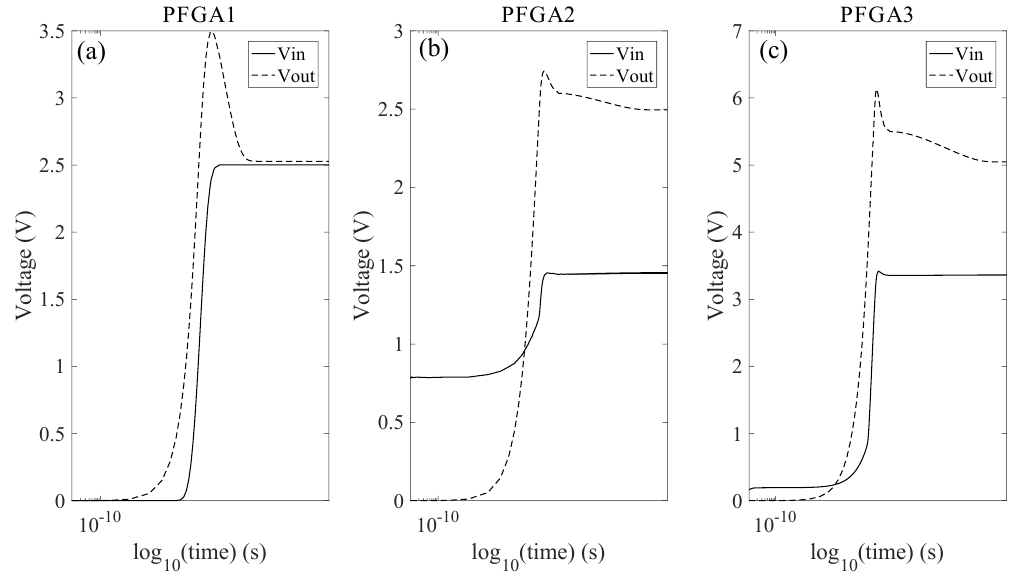
Figure 12. Initial transient analysis of the PFGA after compensation. ( a ) PFGA1. ( b ) PFGA2. ( c )